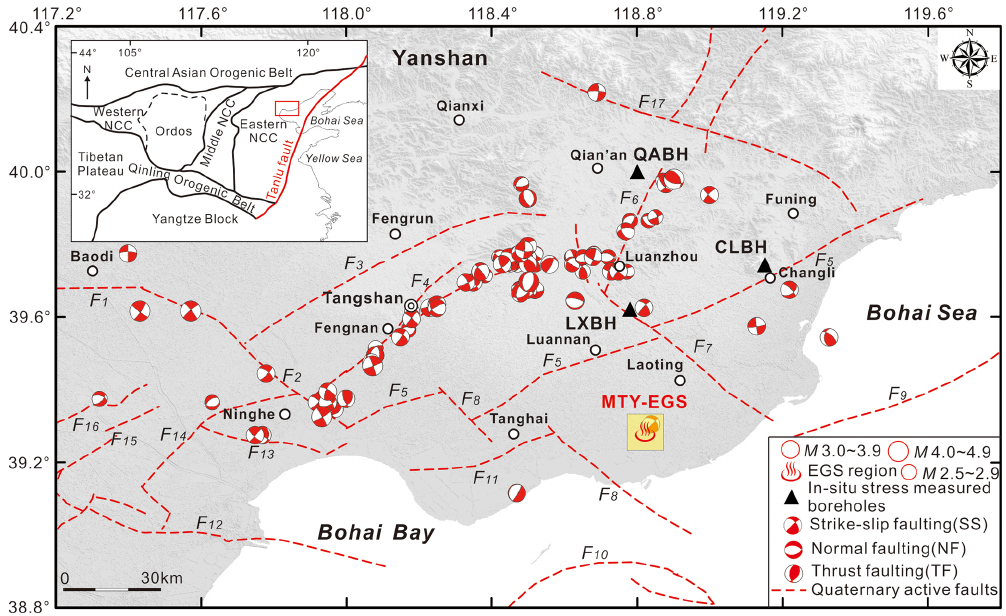
Figure 2. Focal mechanisms from 98 earthquakes ( M ≥ 2 . 5) from 2006 to 2019 in the Tangshan seismic region (gathered from Lin et al., 2017) and in situ-stress-measured boreholes (black triangles) by the hydraulic fracturing method in the north of the MTY EGS field (Tan et al., 2014; Niu et al., 2015; Feng et al.,